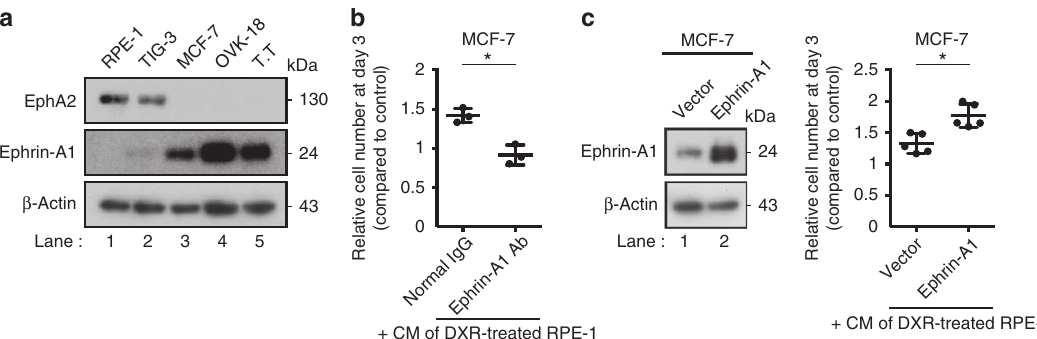
Figure 5 | Ephrin-A1 mediates the growth-promoting effect of sEV-associated EphA2. ( a ) Immunoblotting of EphA2, ephrin-A1 and b -actin in the WCL of indicated cell lines. ( b ) Relative numbers of MCF-7 cells grown for 3 days in the presence of CM compared with the number of cells grown for 3 days in normal medium. Normal rabbit IgG or rabbit anti-ephrin-A1 IgG (AER-031; Alomone) was added to the medium at a concentration of 5 m gml (cid:3) 1 . CM was prepared from DXR-induced senescent RPE-1 cells. ( c ) Immunoblotting shows successful overexpression of ephrin-A1 in MCF-7 cells. Dot plot represents the relative numbers of MCF-7 cells grown for 3 days in the presence of CM compared with the number of cells grown for 3 days in normal medium. Empty vector or ectopic ephrin-A1 was expressed in MCF-7 cells. CM was prepared from DXR-induced senescent RPE-1 cells. Replicates are biological replicates ( n ¼ 3 for b and n ¼ 5 for c ). Error bars indicate s.d. * P o 0.05 (two-tailed t